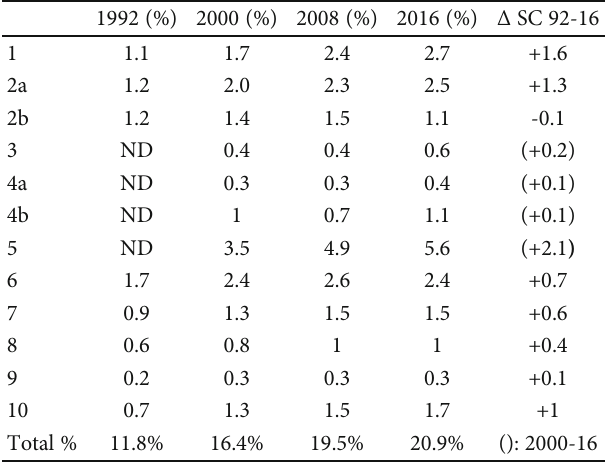
Table 5: Robson ’ s 10-Group Classi fi cation of Flemish women giving birth in 1992-2000-2008-2016: absolute contribution of cesarean sections per group to the total cesarean section rate. ND = no data.